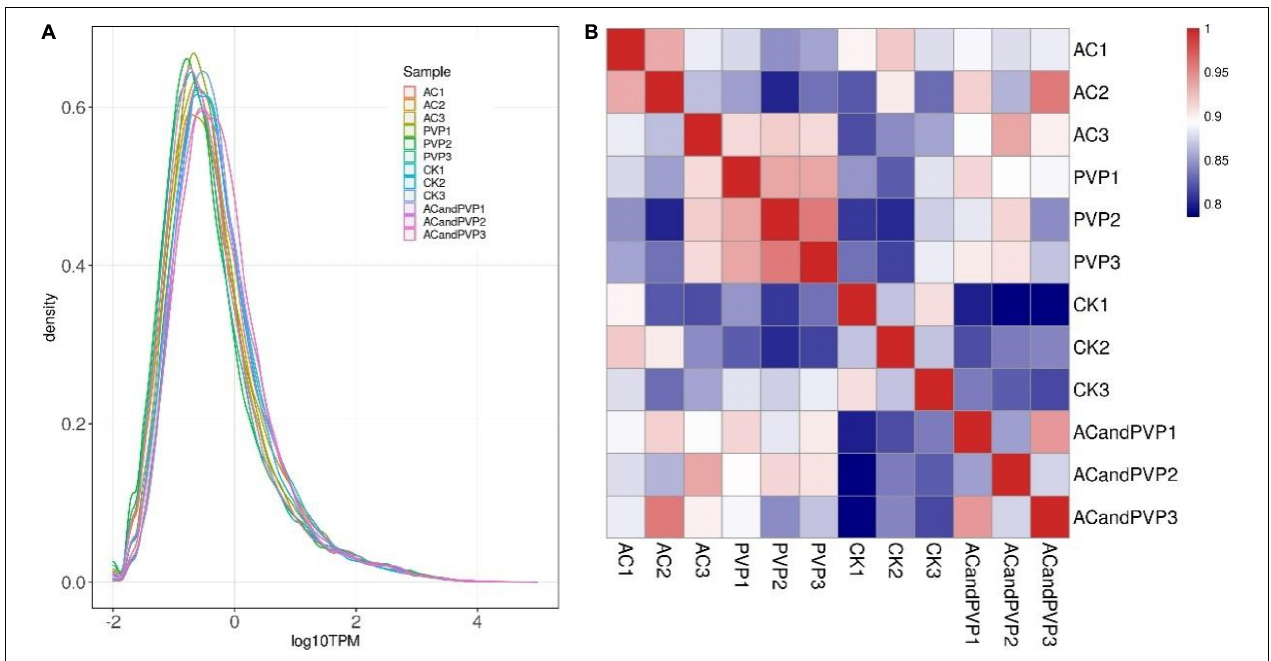
FIGURE 3 | Gene expression abundance distribution map and sample correlation heat map. (A) The curves in different colors in the figure represent different samples, with the X -axis representing log10 (TPM) of the corresponding gene and the Y -axis representing probability density. Generally speaking, the number of differentially expressed genes (DEGs) only accounts for a small part of the whole gene, and a few DEGs have little influence on the distribution of the expression level of samples. In most cases, samples should have a similar distribution of expression levels; (B) the closer the correlation coefficient is to 1, the higher the similarity of expression patterns between samples, and the degree of correlation is positively correlated with the depth of